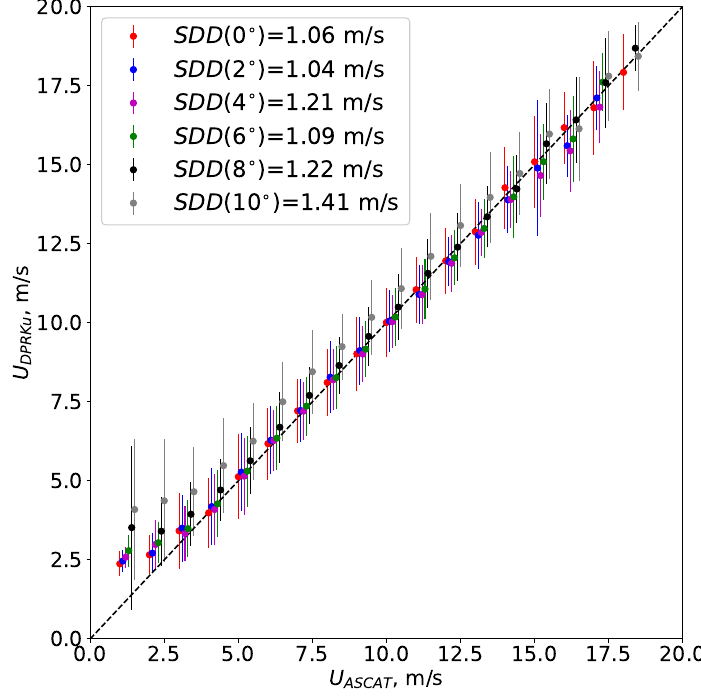
Figure 9. Wind speed comparison between DPR winds and collocated ASCAT winds for different parts of the swath, corresponding to the footprints of beam with incidence angles 0 ◦ , 2 ◦ , 4 ◦ , 6 ◦ , 8 ◦ and 10 ◦ .